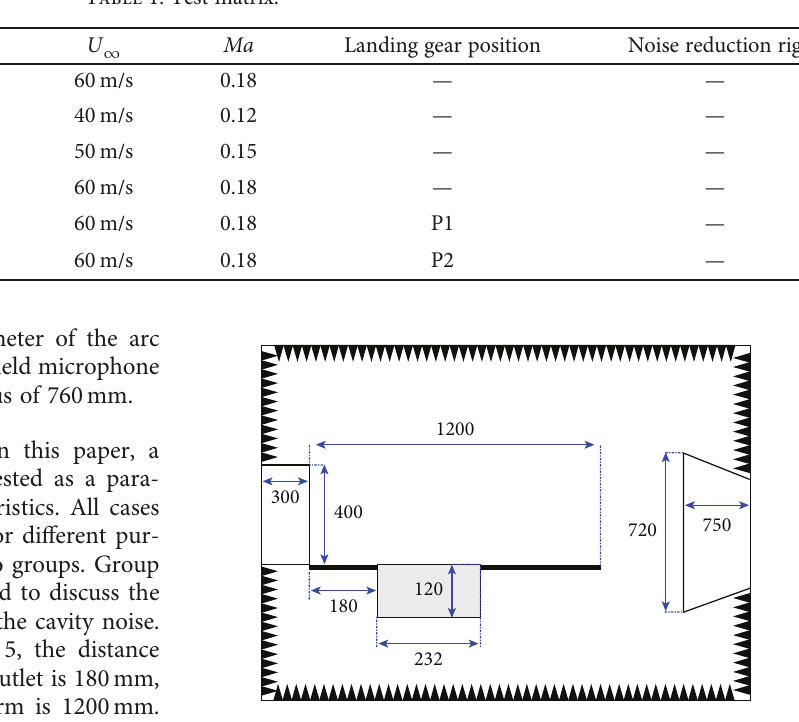
Figure 5: Test setup for the cavity noise characterization with a landing gear model (in